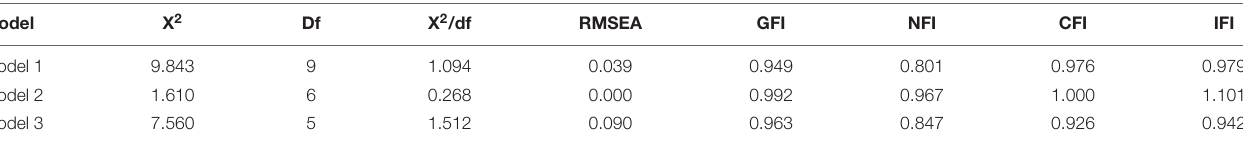
TABLE 5 | Fit index of the path analysis models for total social support